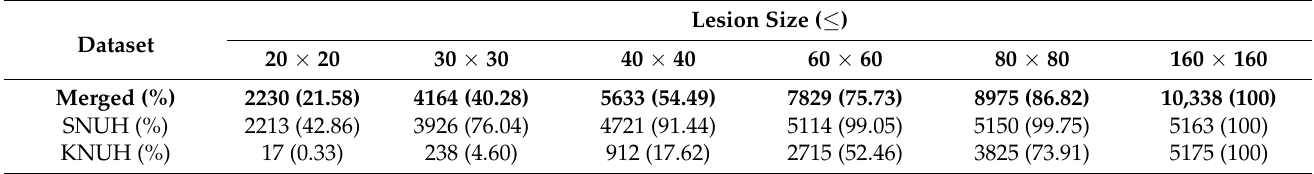
Table 2. Distribution of lesion sizes in a dataset.